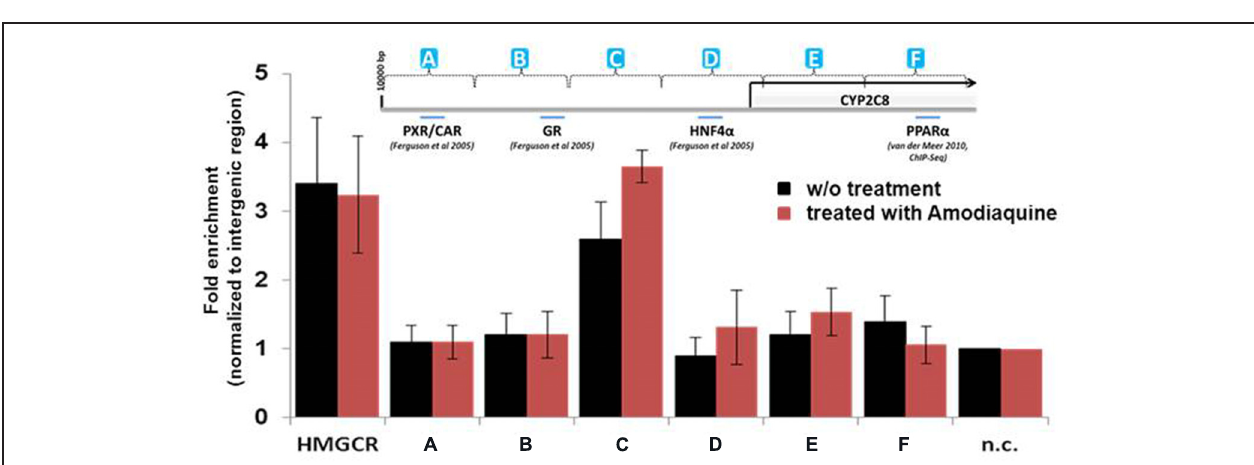
FIGURE 4 | Binding of PPAR α to the CYP2C8 promoter in vivo . Precipitated DNA from HepaRG cells without (w/o) treatment or after treatment with amodiaquine (10 μ M for 6 h) was purified and was used, together with input DNA, as template for Sybr-Green PCR using a total of 12 primer pairs spanning approximately 10 kb of the CYP2C8 promoter region. Raw Ct (cycle threshold) values were normalized to input DNA to calculate the percentage of DNA immunoprecipitated. Primers encompassing the PPRE of the human HMGCR gene were used as positive control. Means relative to negative control primer pair (n.c.) are shown. (A–F) Schematic representation of CYP2C8 promoter regions, which were subjected for the ChIP analysis. Promoter scheme includes binding sites of previously described transcription